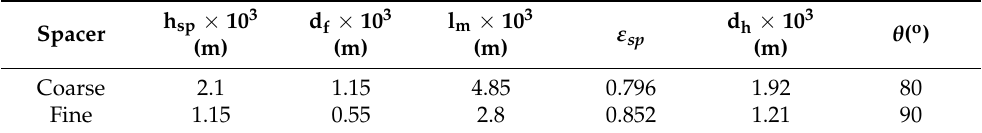
Table 3. Characteristics of coarse and fine